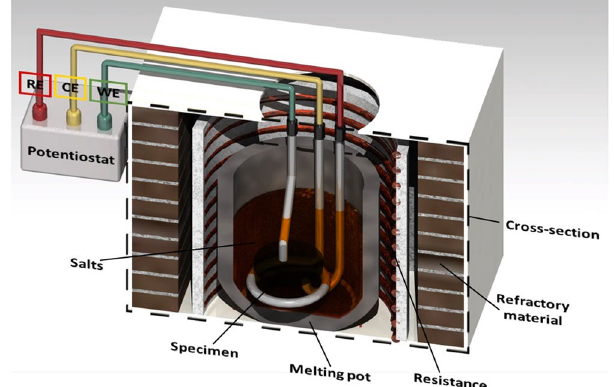
Figure 1. Schematic representation of the high temperature electrochemical cell used for the measurements. RE, CE and WE are the reference, counter and working electrodes,